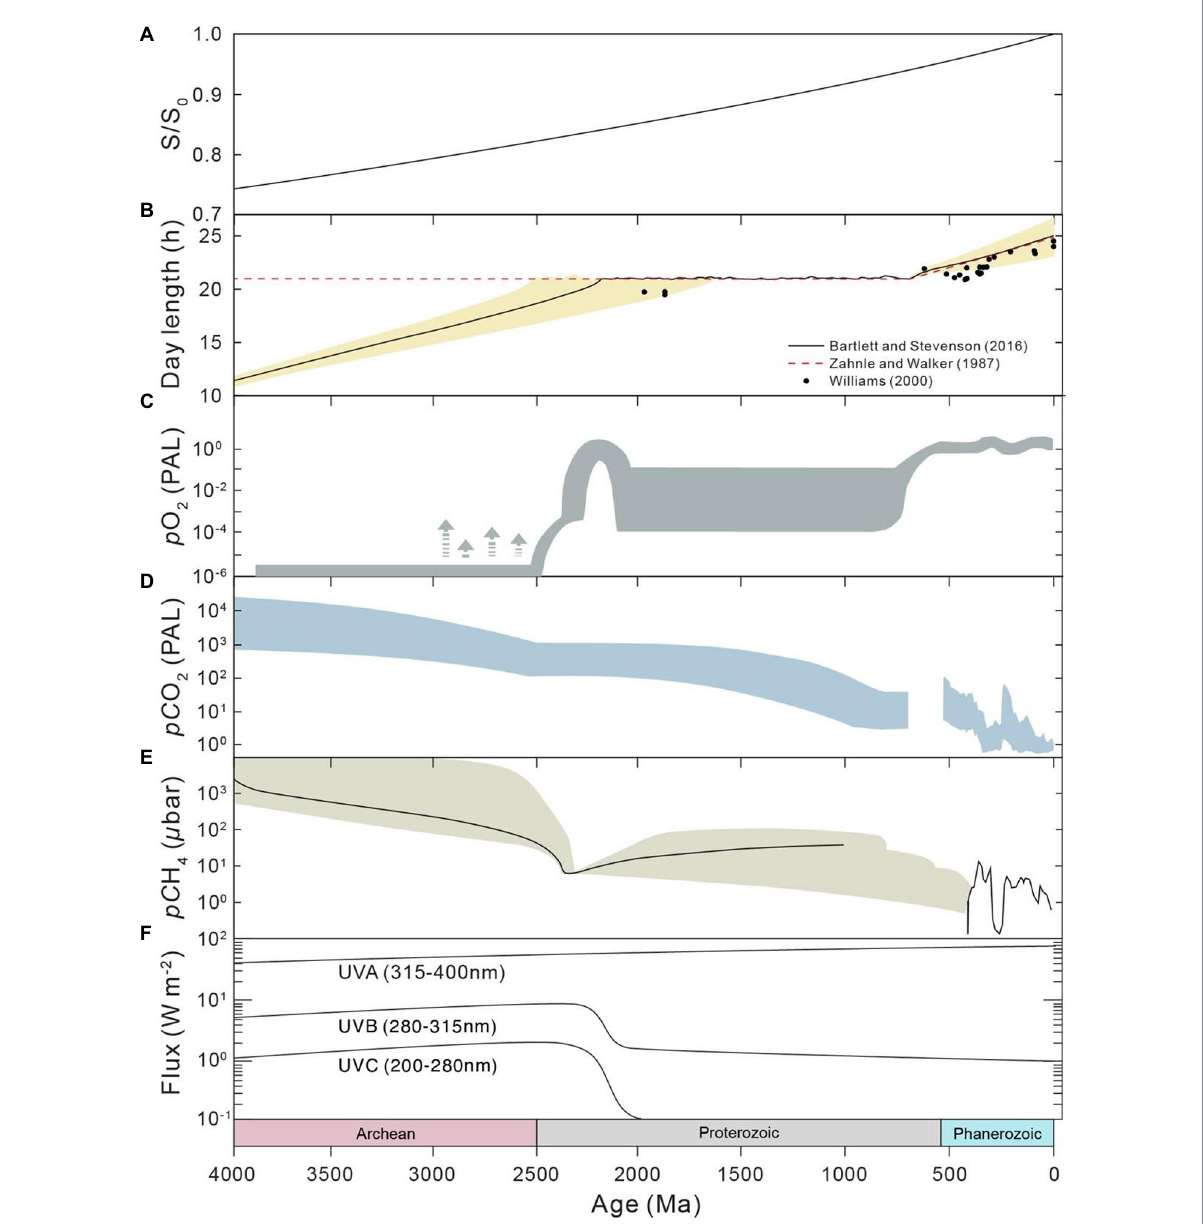
FIGURE 2 Evolution of astronomical conditions and atmospheric composition throughout Earth history. (A) Solar luminosity, derived from Kasting (1987). (B) Day length. (C) Atmospheric p O 2 , after Lyons et al. (2014). (D) Atmospheric p CO 2 . Results of the Precambrian (left) are from Kasting (1987), whereas those of the Phanerozoic (right) are from Royer et al. (2004). (E) Atmospheric p CH 4 , derived from Catling and Zahnle (2020). (F) Ultraviolet (UV) radiation at the ground, modified from Cockell